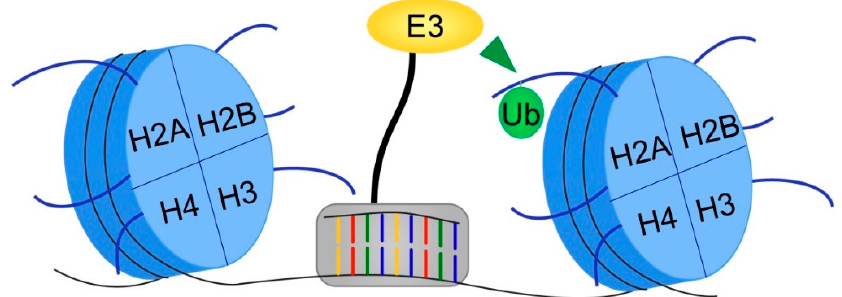
Figure 4. Schematic depicting an epigenome editing tool to target histone ubiquitination. Epigenome editing employs a fusion protein consisting of a DNA sequence-specific recognition domain (gray box) and a functional chromatin-modifying domain, such as a histone E3 ubiquitin ligase, in order to modulate a chromatin post-translational modification at a specific locus.